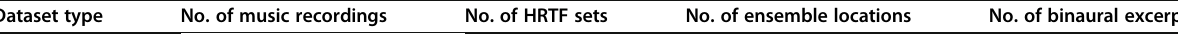
Table 1 Train and test data split in the repository of binaural audio excerpts Dataset